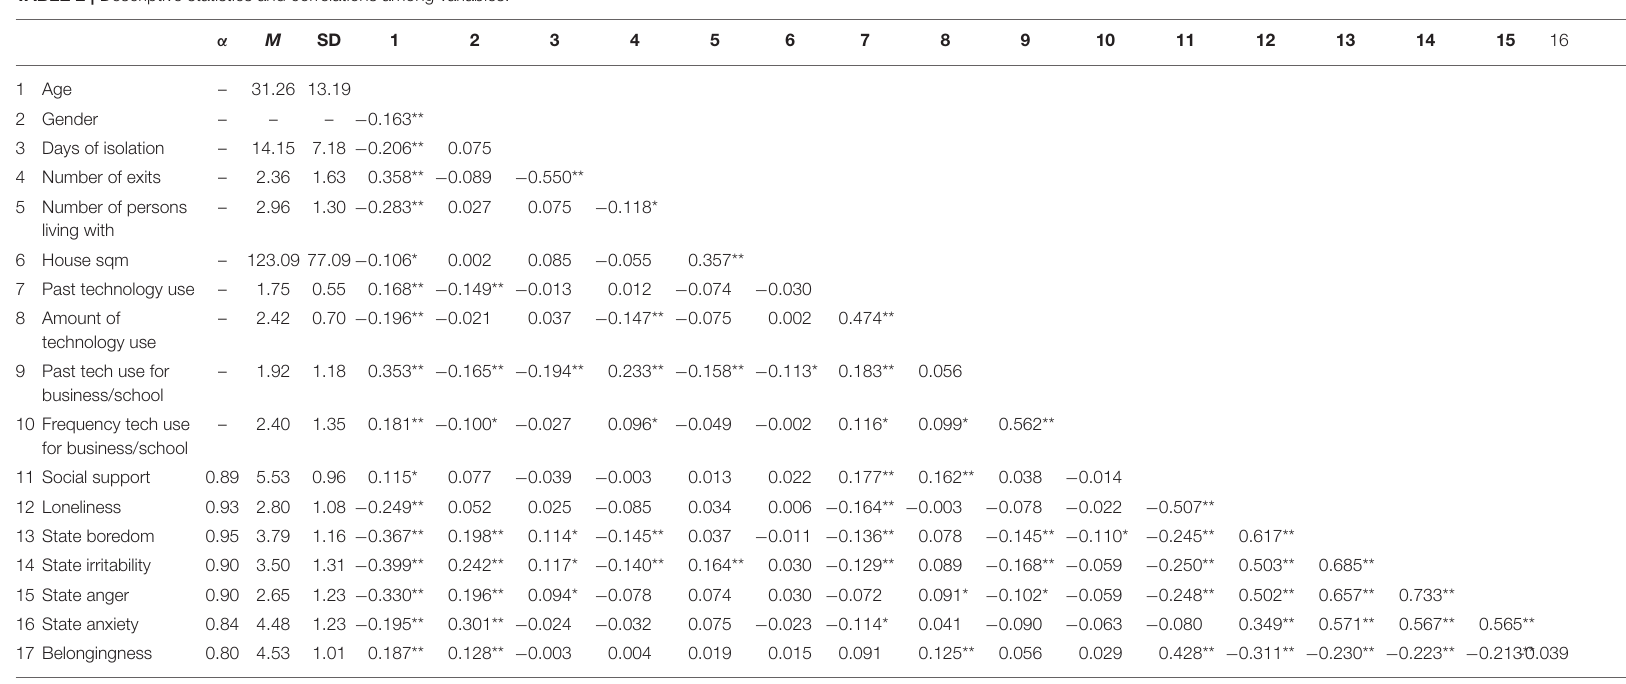
TABLE 2 | Descriptive statistics and correlations among